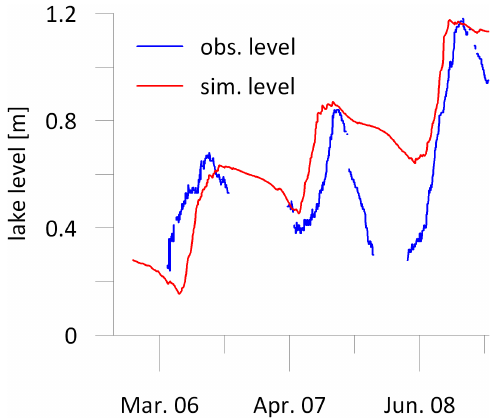
Fig. 7. Observed and simulate lake levels in meter for 2006 to